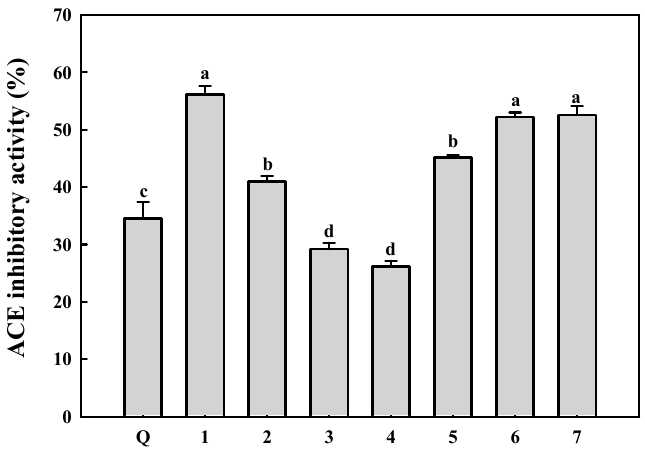
Figure 6. ACE inhibitory activities of ACE inhibitors isolated ( 1 – 7 ). Q (quercetin) was used as positive control. The isolated compounds were assayed at the concentration of 1 mM. Values are expressed as mean ˘ SD ( n = 3). a–d Results with a different letter differ significantly ( p <